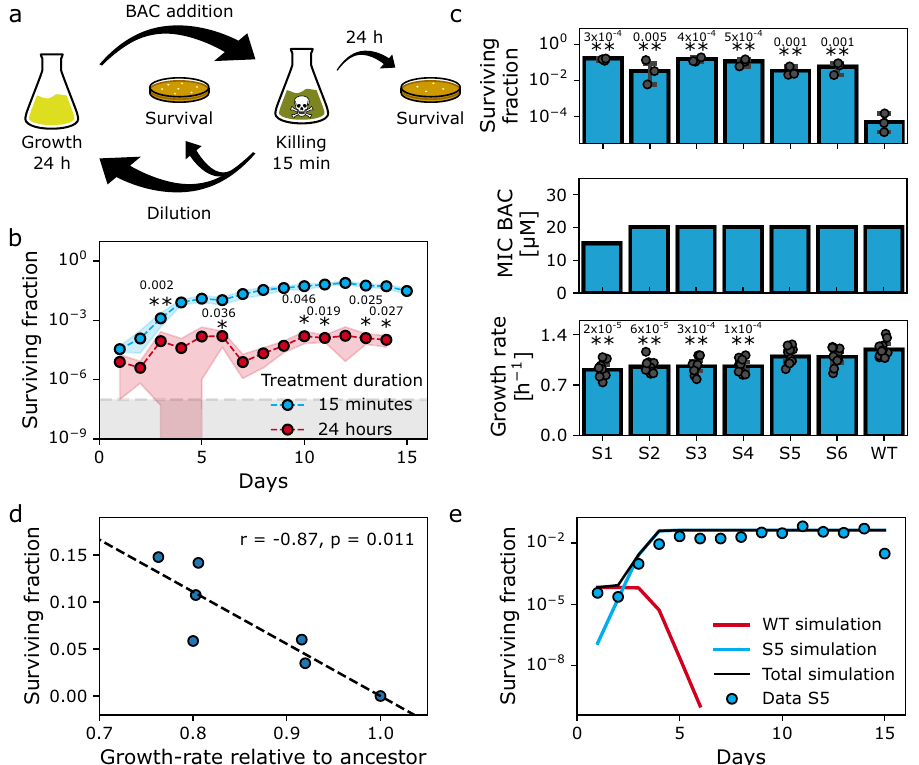
Fig. 2 Periodic failure of disinfection rapidly selects for tolerance against BAC. a Schematic of the evolution experiment selecting for the survival of BAC disinfection. b Daily exposure to BAC rapidly selects for tolerance. Shown are the geometric means ± 95% C.I., n = 6 biological replicates. The fi rst round that is signi fi cantly different from the beginning of the treatment is marked by asterisks. (cid:1) p < 0.05; (cid:1)(cid:1) p < 0.01 (two-tailed paired t-test of log-transformed survival fractions). c Phenotypic characterization of six evolved clones. The surviving fraction of the evolved clones after 20 min of BAC treatment is increased ( n = 3 biological replicates). Signi fi cance of difference to wild-type indicated by asterisks: (cid:1) p < 0.05; (cid:1)(cid:1) p < 0.01 (two-tailed t-test of log- transformed survival fraction). The MIC against BAC is not affected in the evolved clones ( n = 4 biological replicates). The growth rate of the evolved clones is reduced, signifying the cost of tolerance ( n = 10 biological replicates). Signi fi cance of difference to wild-type indicated by asterisks: (cid:1) p < 0.05; (cid:1)(cid:1) p < 0.01 (two-tailed unpaired t-test of growth rates). Error bars show 95% con fi dence intervals. For the surviving fraction, the geometric mean is reported. For the growth rate, the arithmetic mean is reported. For the MIC, the maximal value from four biological replicates is reported. d Trade-off between tolerance and growth rate in individual clones. Signi fi cance of correlation: two-sided test with t-distribution of the test statistic. The data are taken from panel ( c ). e Population dynamics can be explained by trade-off between growth-rate and tolerance of individual clones. Simulations of survival fraction during the serial passage experiment with alternating growth and kill cycles (lines) quantitatively reproduce the experimental data (circles). The parameters for growth rate and survival fraction are the same as for clone S5 in panel ( c ). Simulations of all individual clones can be found in Fig. S3. Source data are provided as a Source Data fi le. Exact p -values are indicated above the